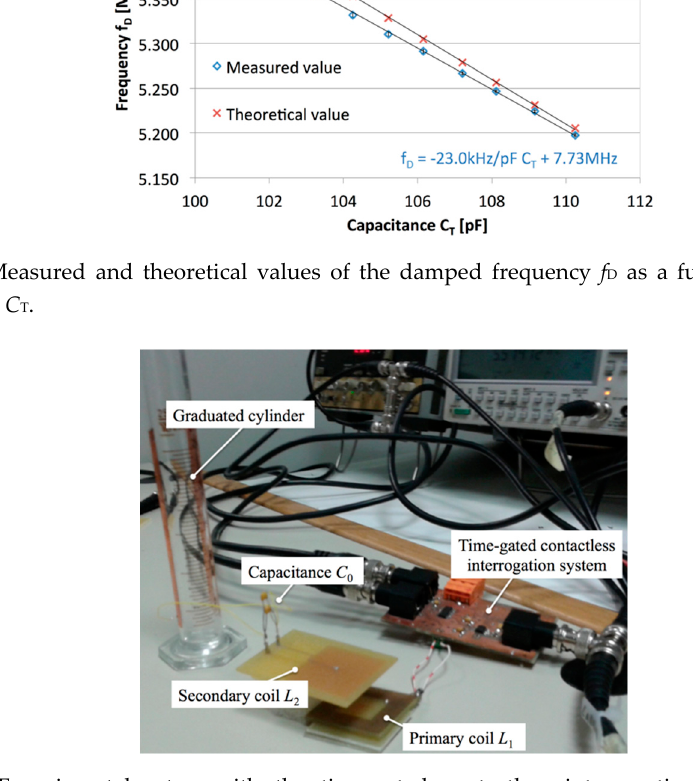
Figure 5. Experimental setup with the time-gated contactless interrogation system, and the graduated cylinder used for liquid-level measurements.